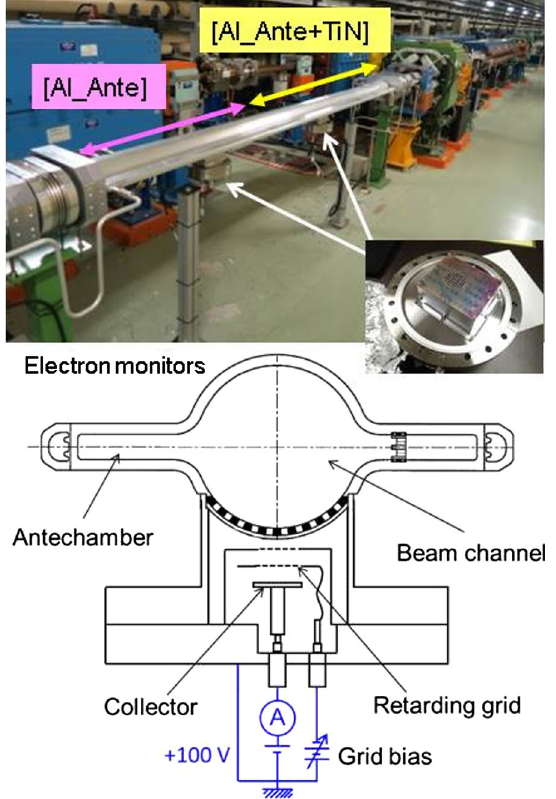
FIG. 8. Electron monitors attached to a test chamber with antechambers in an arc section of the LER. Here, [Al_Ante] and [Al Ante þ TiN] denote the Al region without and with TiN coating, respectively.